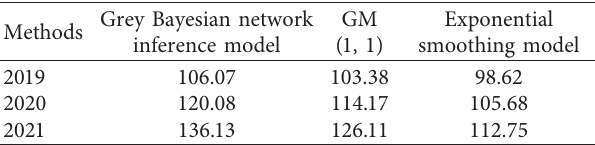
Table 5: Flight time forecast of the aviation industry production (unit: 10,000